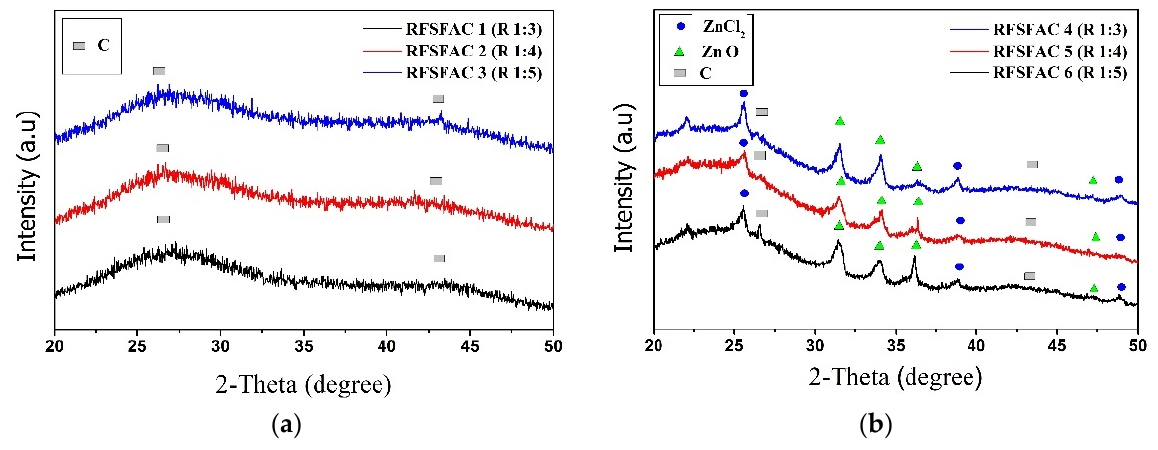
Figure 2. XRD patterns of RFSFAC products prepared using different impregnation ratios and activating agents. ( a ) KOH; ( b ) ZnCl 2 .